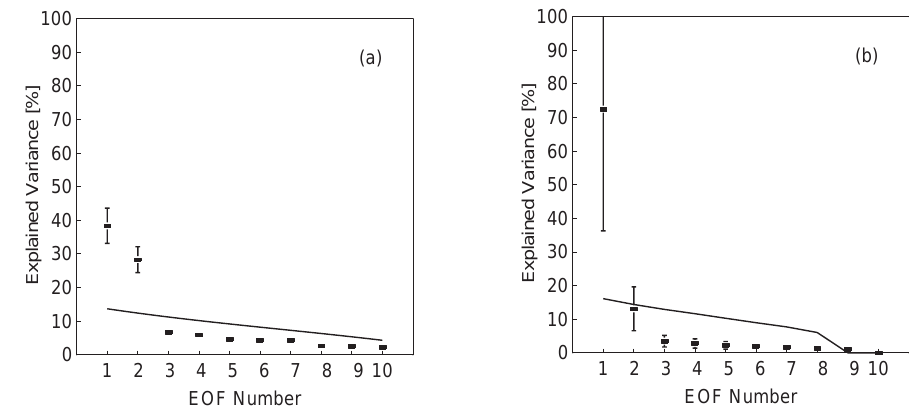
Figure 6. Variance spectrum of the spatial (a) and temporal (b) analysis in the arable test site. Error bars indicate the 95% confidence interval according to Eq. (6); the solid line represents the significance limit calculated by Monte Carlo simulation.